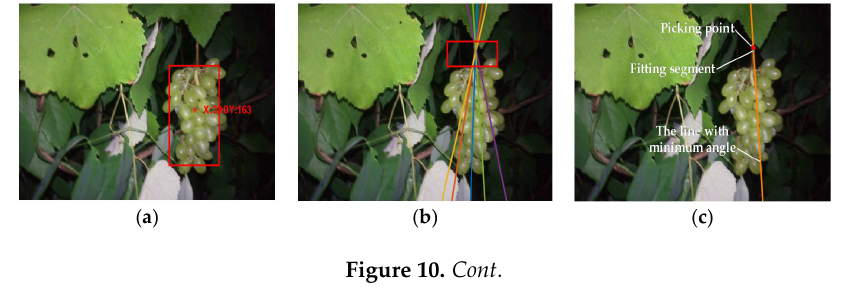
Figure 9. The calculation of the picking point. ( a ) Horizontal line and vertical line; ( b ) detection of line angle range; ( c ) determination of picking point; ( d ) fruit area; ( e ) the region of interest (red box) and the Hough detection results; ( f ) picking-point